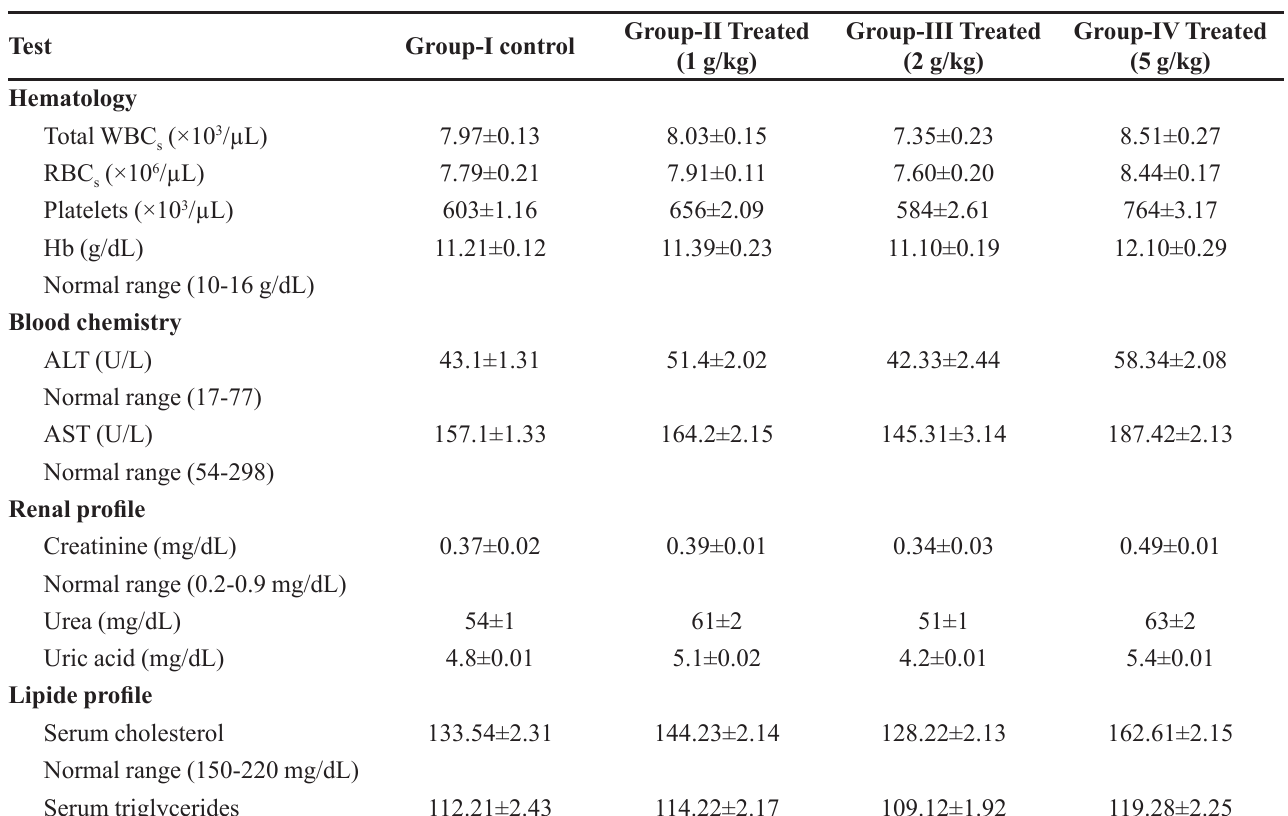
Organ weight is expressed as relative organ body weight ± SEM TABLE IV - Hematology and blood biochemistry of mice Test